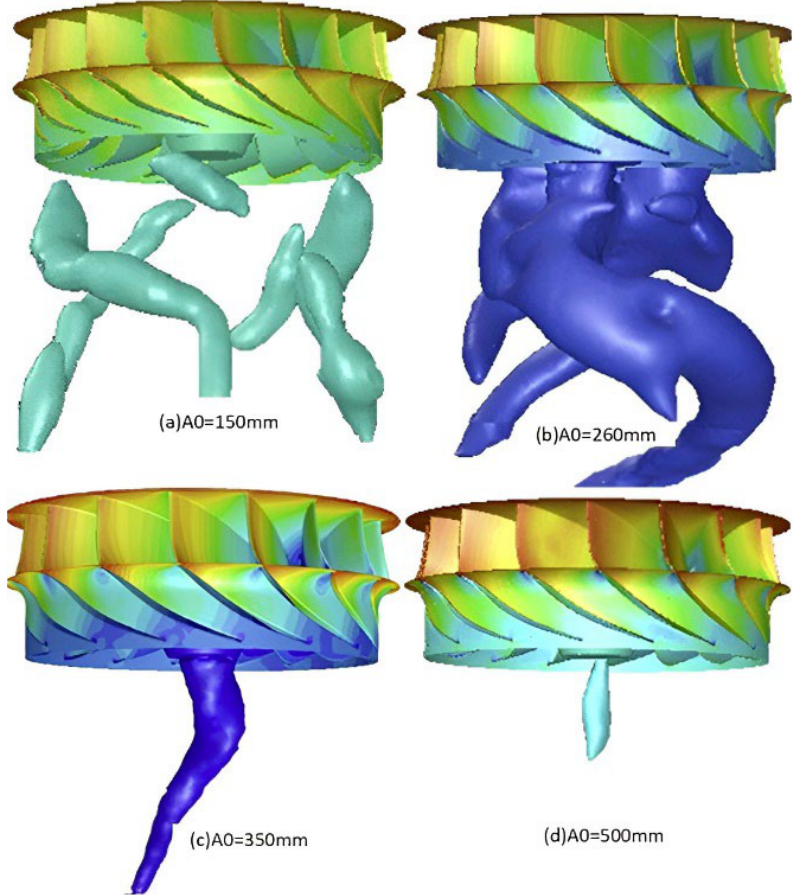
Figure 19. Under different guide vane opening, shape of draft tube vortex rope [48].